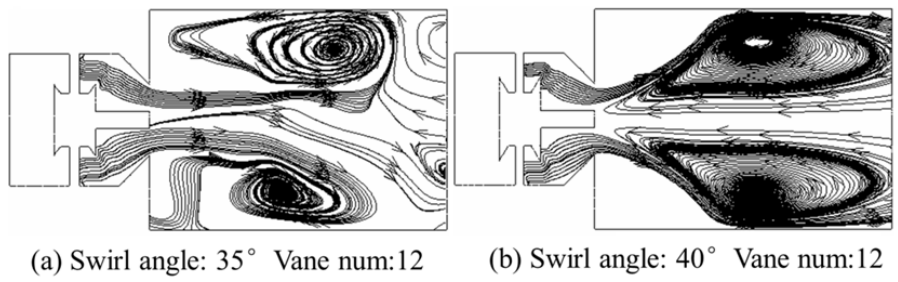
Figure 9. The streamline of combustor at different swirling intensity.